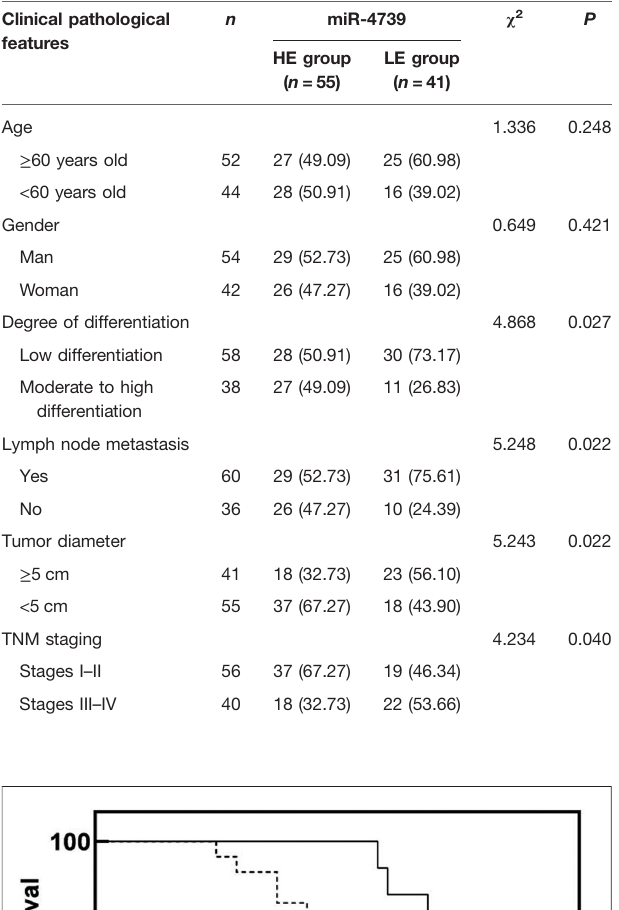
TABLE 2 | Relationship between miR-4739 expression level and clinical pathological features (n,%). Clinical pathological